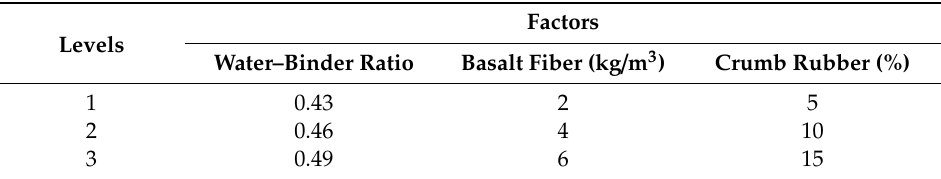
Table 4. Parameters in the orthogonal experimental design.